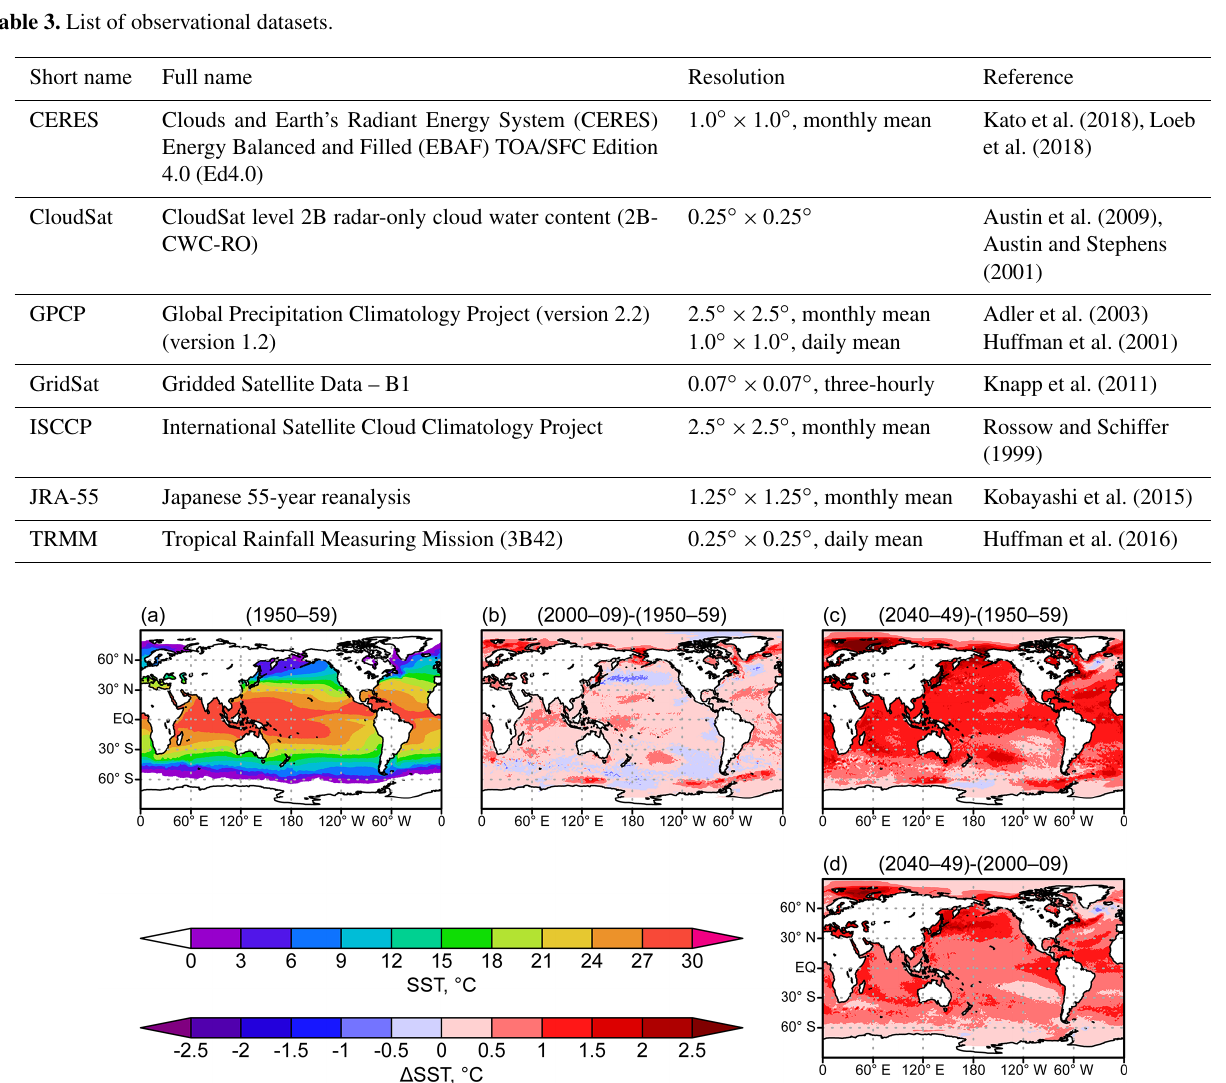
Figure 1. Decadal mean horizontal distribution of sea surface temperature (SST) prescribed in the model averaged for the 1950s (a) . Dif- ferences between the 2000s and the 1950s (b) , the 2040s and the 1950s (c) , and the 2040s and the 2000s (d) are also shown. Units are ◦